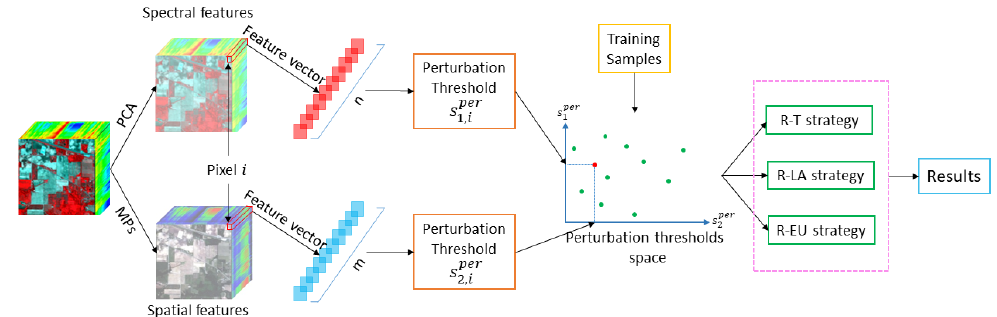
Figure 12. The proposed method for hyperspectral image classification based on Robust Dynamic Classifier Selection